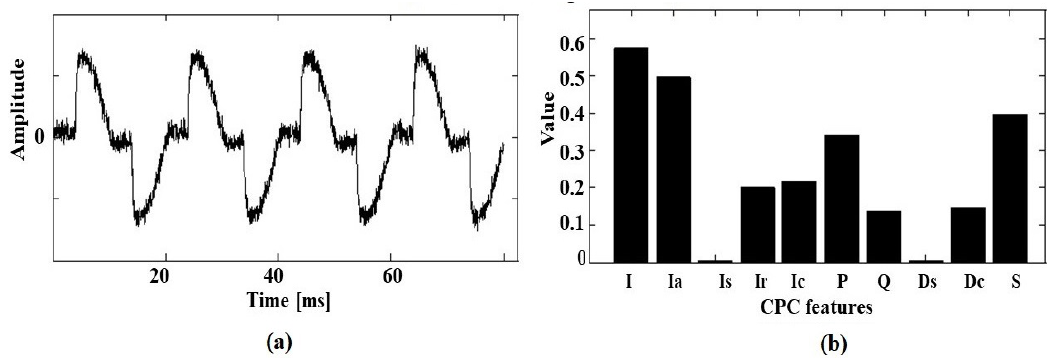
Figure 12. Noisy dimmer with excitation angle of 70 ◦ : ( a ) simulated current waveform; and ( b ) CPC